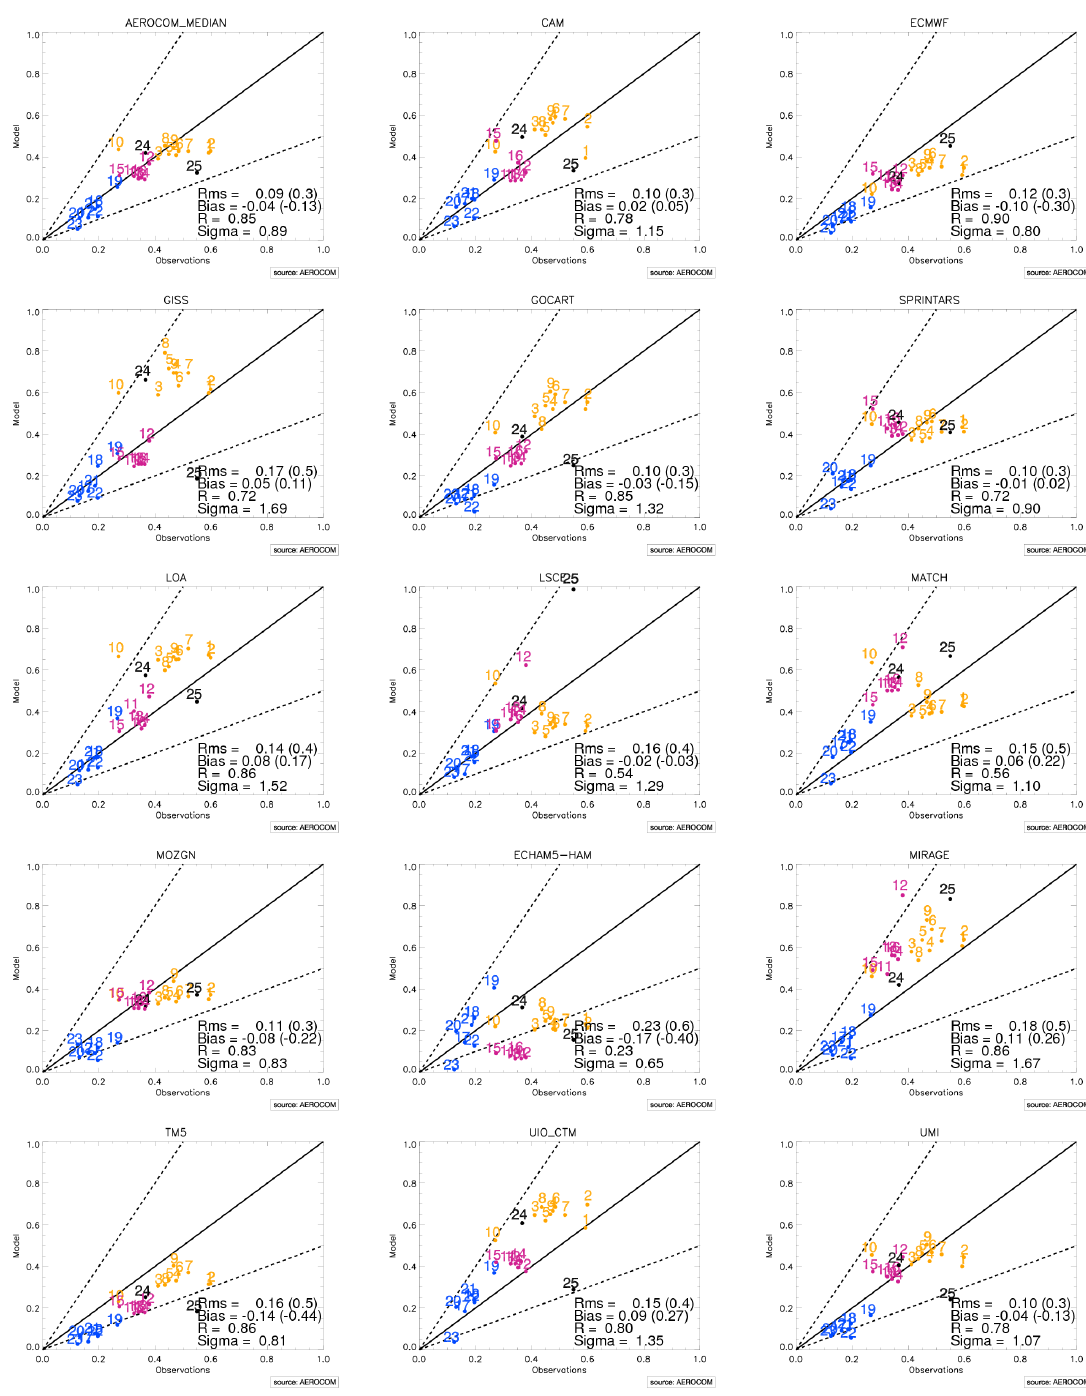
Fig. 9. Averaged AOD at 550nm versus modeled one at dusty stations of the AERONET network. Data from the climatology based on the multi-annual database 1996–2006 are used. Stations are regionally grouped into African (orange), Middle East (Violet) and Caribbean- American stations (Blue) and stations elsewhere (black). Location of each station is illustrated in Fig. 8. Name and location of each station is given in Table S3 in the Supplement. Root mean square error (RMS), bias, ratio of modeled and observed standard deviation (sigma) and correlation ( R ) are indicated for each model in the lower right part of the scatter plot. Mean normalized bias and normalized root mean square error are given in parenthesis next to RMS and mean bias, respectively. Black continuous line is the 1:1 line whereas the black dotted lines correspond to the 2:1 and 1:2